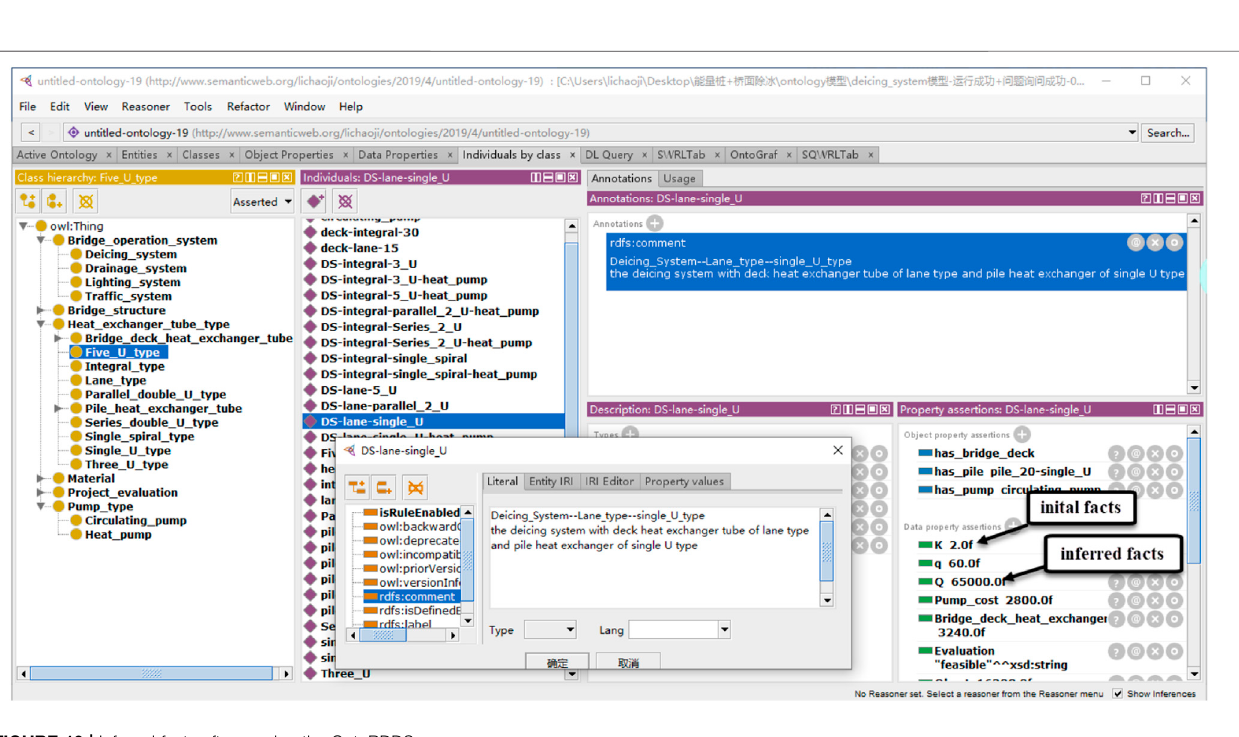
FIGURE 10 | Inferred facts after running the OntoBDDS.